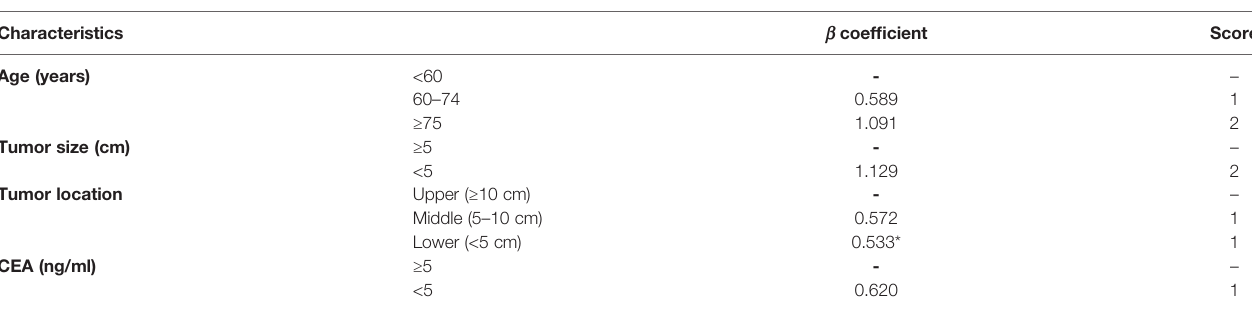
TABLE 4 | Scoring system.